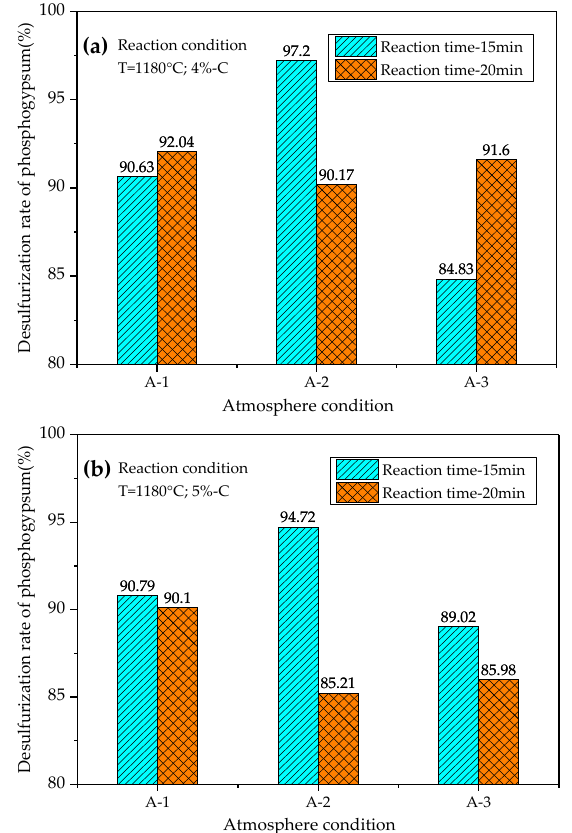
Figure 7. Desulfurization rate of phosphogypsum under different atmosphere conditions ( Ψ ): ( a ) the reaction temperature 1180 °C, time 15min, carbon powder addition 4%; ( b ) the reaction temperature 1180 °C, reaction time 20min, carbon powder addition 5%.